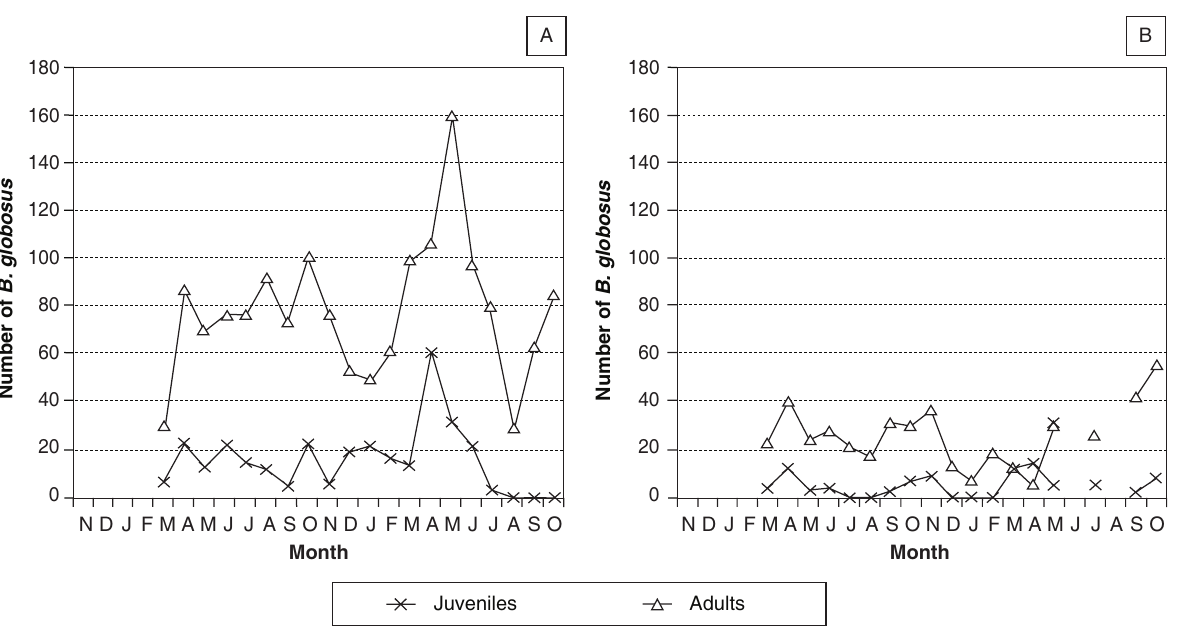
FIG. 5 Monthly variation of juvenile and adult Bulinus globosus snails in the highveld (A) and lowveld (B) communal grazing areas of Zimbabwe for the period November 1998 to October